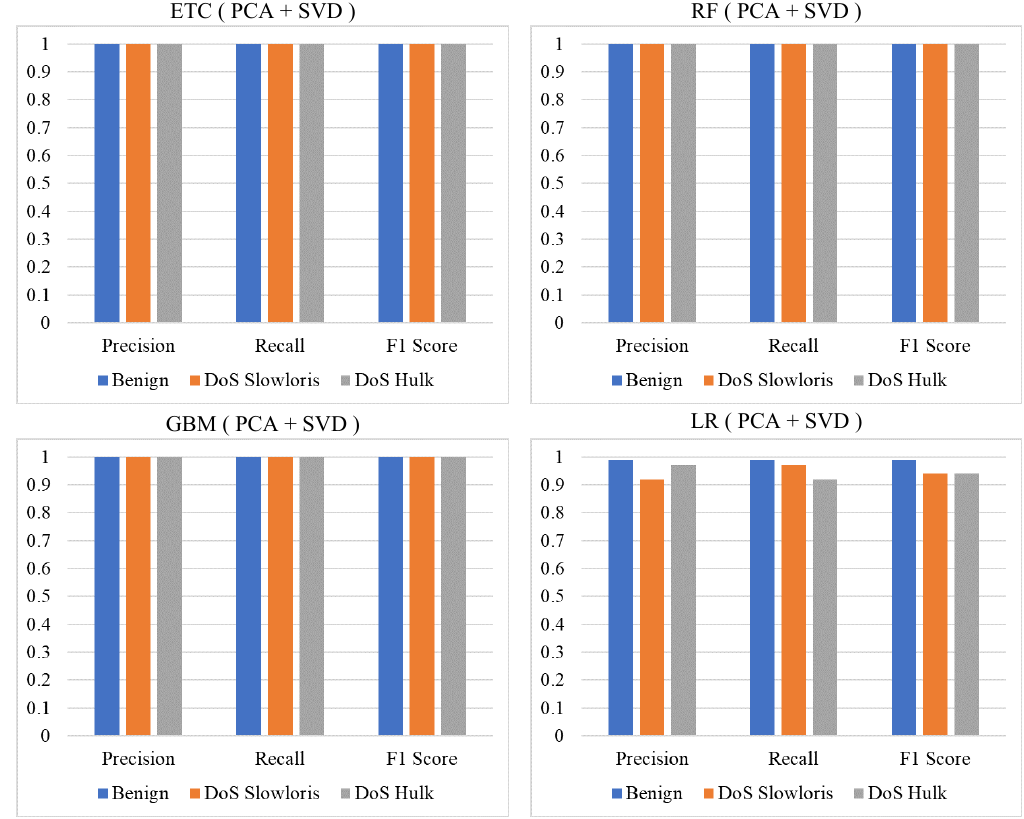
Figure 4. Comparison of performance when PCA and SVD are